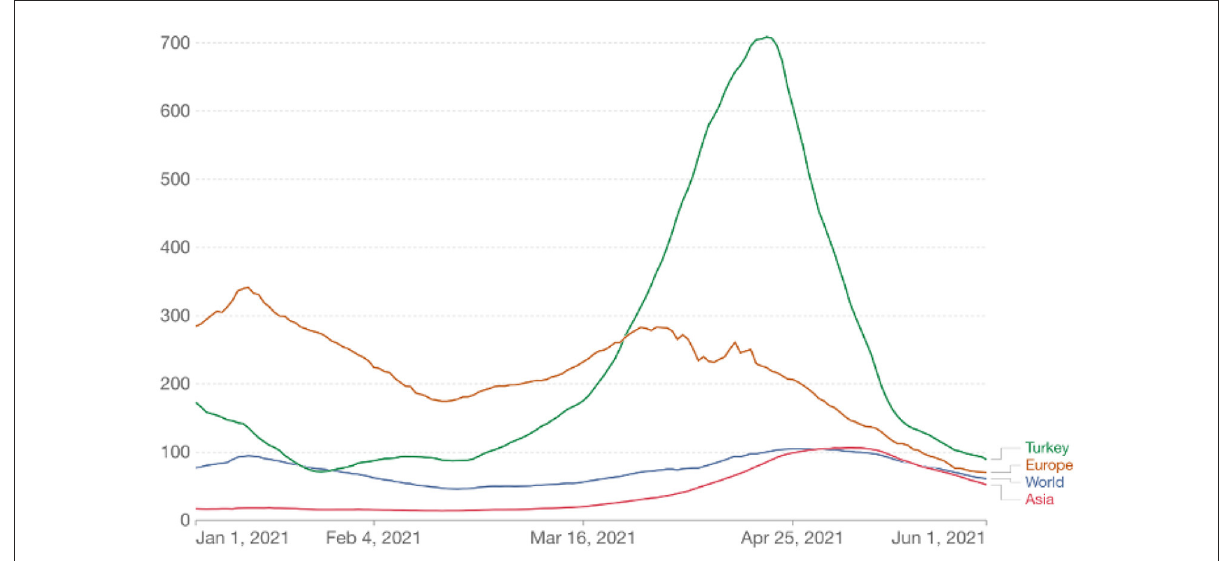
FIGURE1 Daily new confirmed COVID-19 cases per million people (7-day rolling